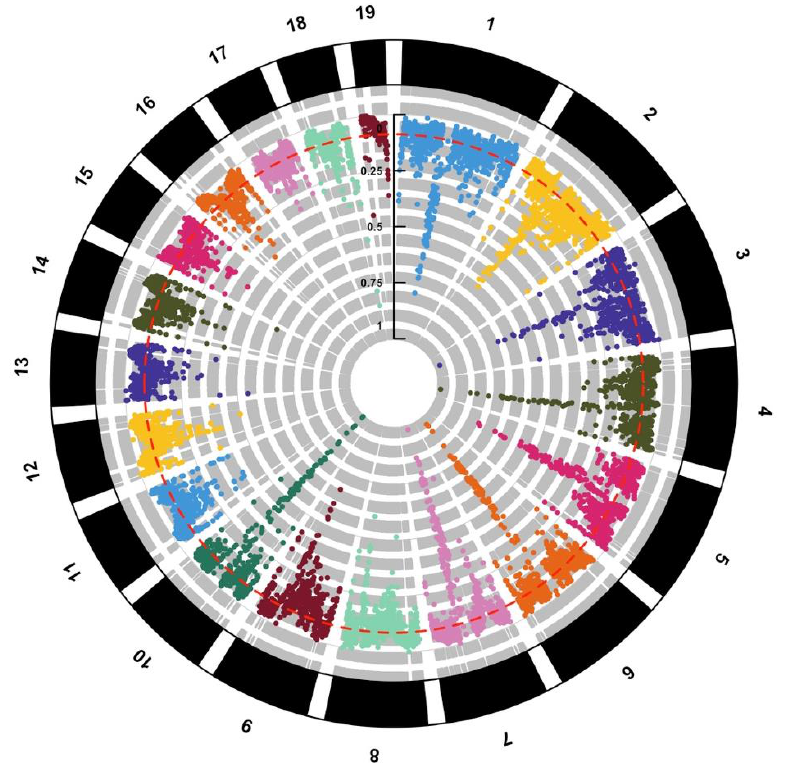
Figure 2. Circular Manhattan Plot showing sliding-window F ST between European and American eel at 19 chromosomes after re-examining data from Pujolar et al. [36]. Average F ST (red dotted line) is